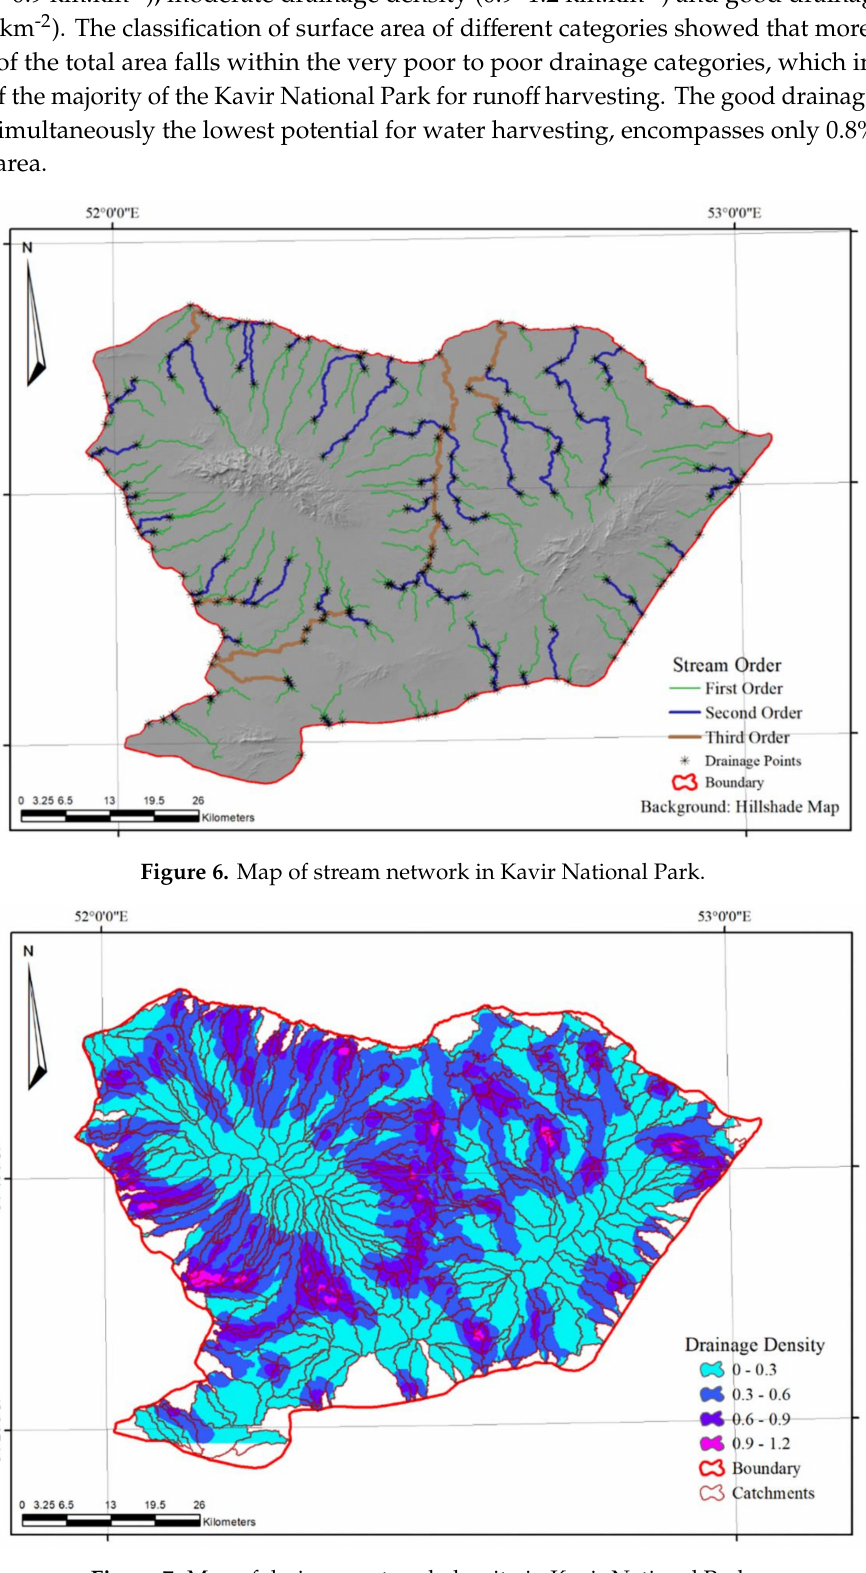
Figure 7. Map of drainage network density in Kavir National